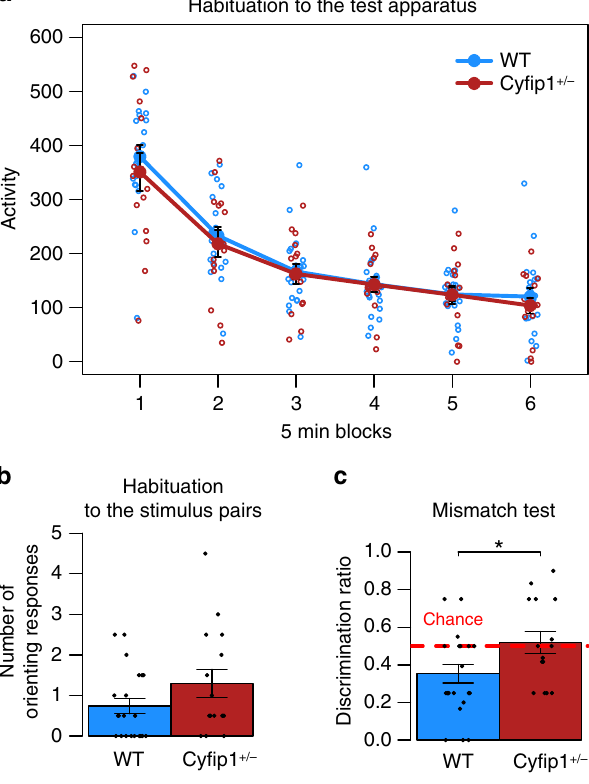
one-way ANOVA revealed no differences in orienting to the cued visual stimuli at the end of the training phase (Fig. 6b, GENOTYPE ( F (1,34) = 2.4, p = 0.62)). During testing rats were presented with both the original training trials (match; i.e. Tone → Steady Light, Click → Flashing Light) and novel mismatch combinations of the same cues (e.g. Tone → Flashing Light, Click → Steady Light), WT rats showed the normal preference 47 – 50 to orient to the visual cues on mismatch trails (relative to match trails) demonstrating their ability to respond to the changed contingencies. In contrast, the Cy fi p1 + / − rats failed to show this preference, instead showing no preference for responding to either the habituated (match) or the novel (mismatch) cues (Fig. 6c, ANOVA: GENOTYPE ( F (1,34) = 5.92, p < 0.05) as indicated by the discrimination ratios (total orienting to matched/total orienting to both matched + mismatched). This pattern of behaviour represents further evidence of a de fi cit in